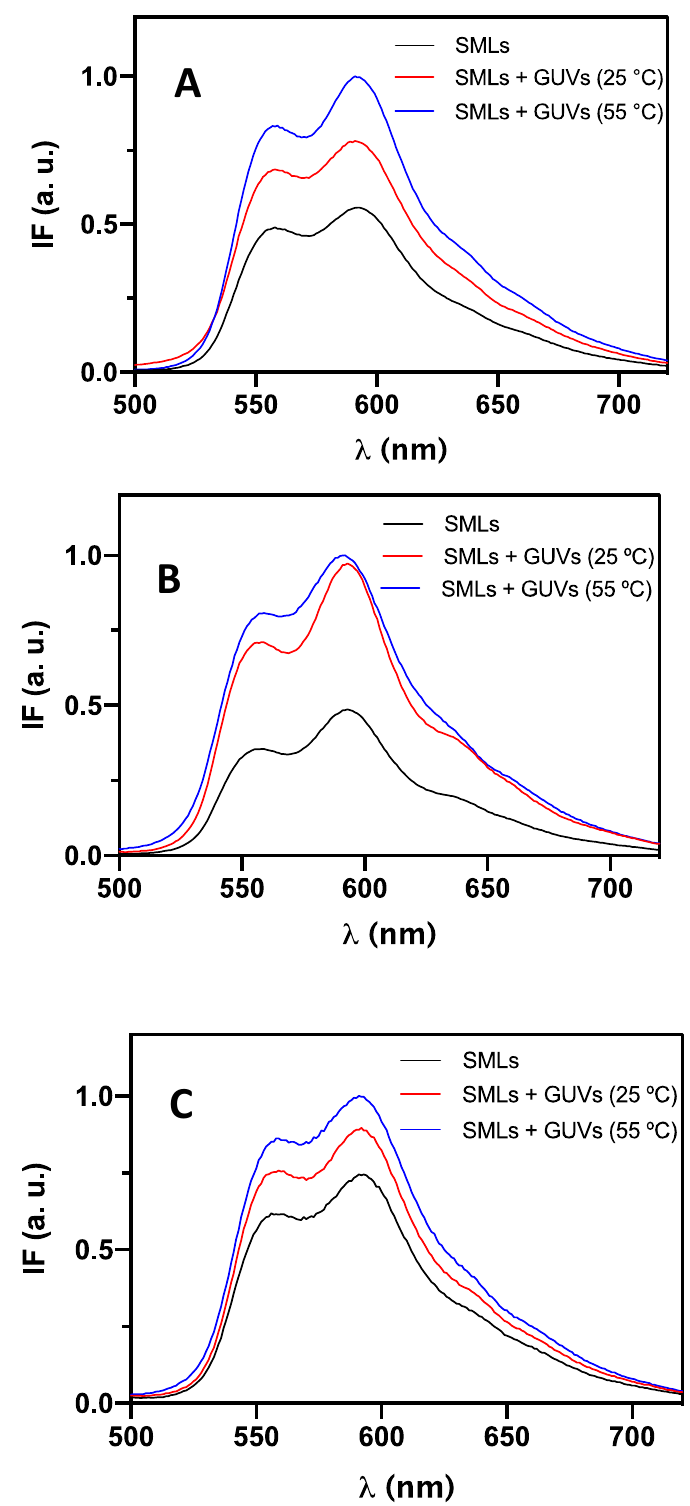
Figure 12. Fluorescence spectra ( λ exc = 480 nm) of doxorubicin in SMLs containing Ca 0.25 Mg 0.75 Fe 2 O 4 , before and after interaction with GUVs at 25 °C and 55 °C, for the dif- ferent lipid formulations. ( A ) DPPC; ( B ) DPPC:DSPE-PEG; ( C ) DPPC:Ch.